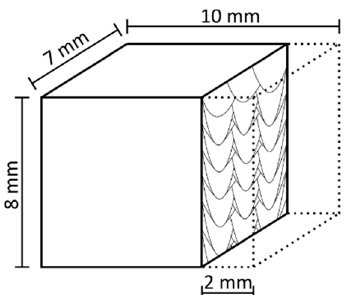
Figure 7. Illustration of resulting cubic test specimen and the preparation plane for further exami- nations of material density, melt pool structure and hardness.